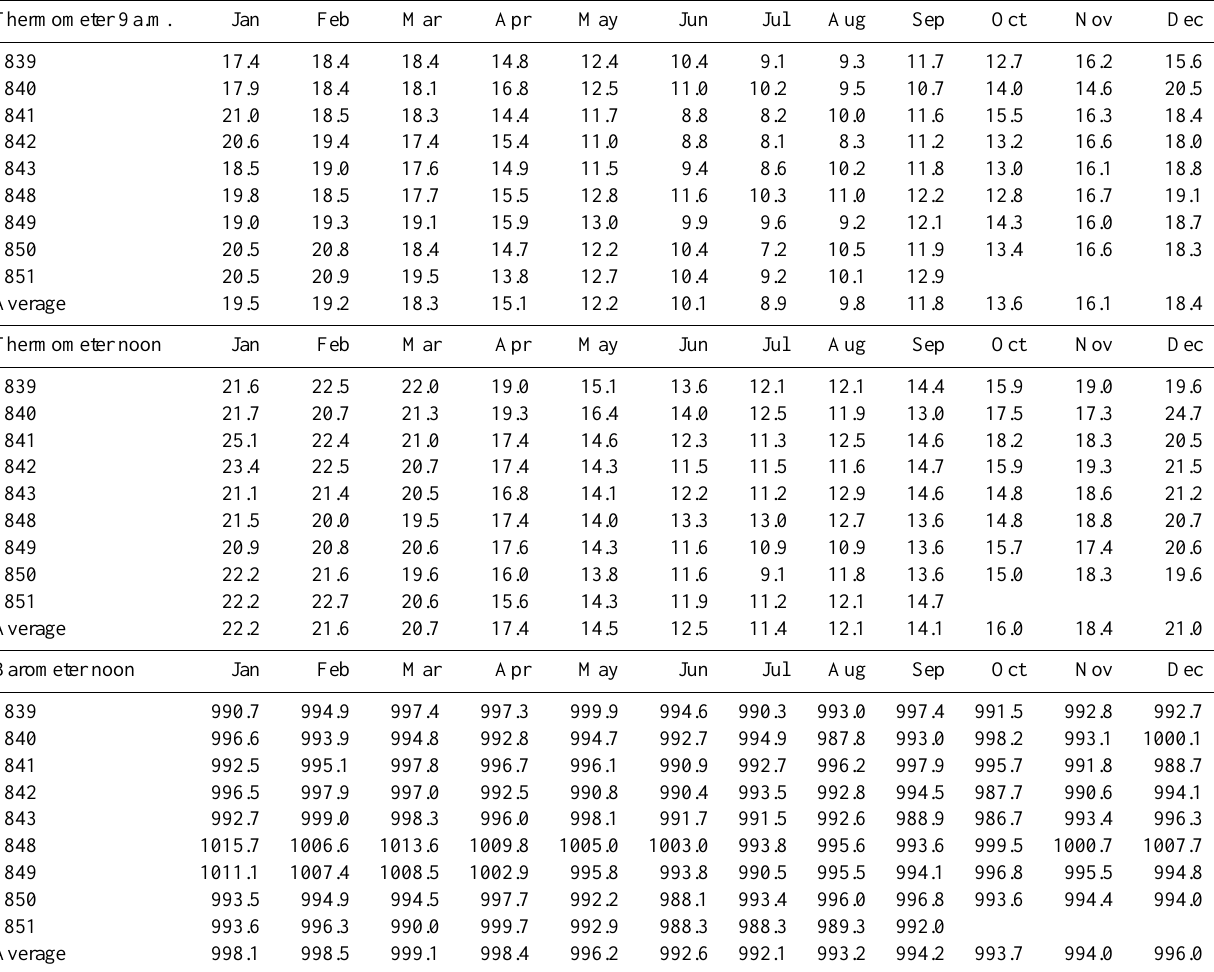
Table 1. Monthly average 9a.m. temperature, noon temperature and noon pressure from the Reverend Richard Davis meteorological diary converted from Fahrenheit to Celsius and inches of mercury to hectopascals. Thermometer